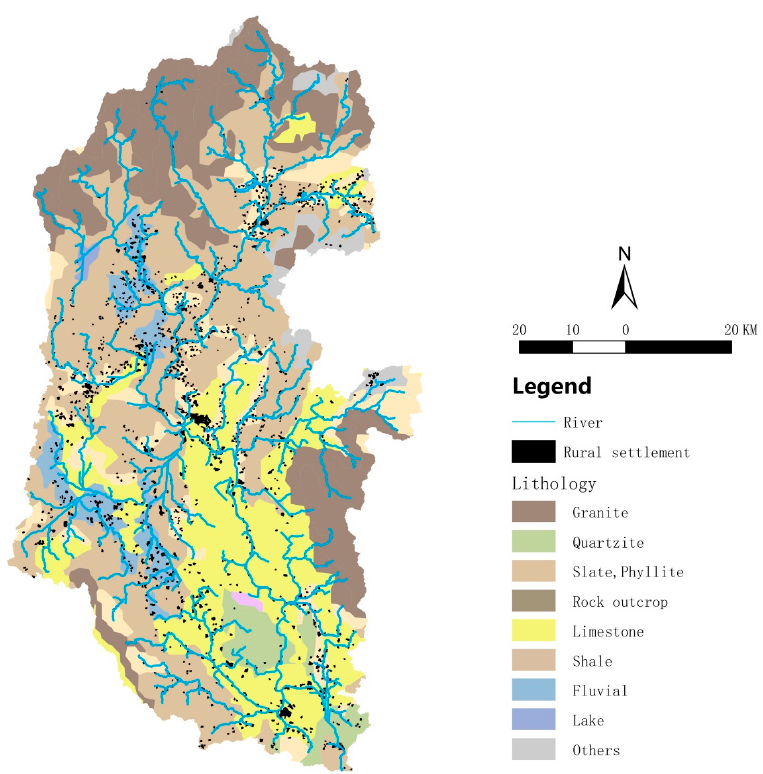
Figure 7. Lithologic geomorphological map of rural settlement distribution in the Lijiang River Basin. Black spots indicate rural settlements.